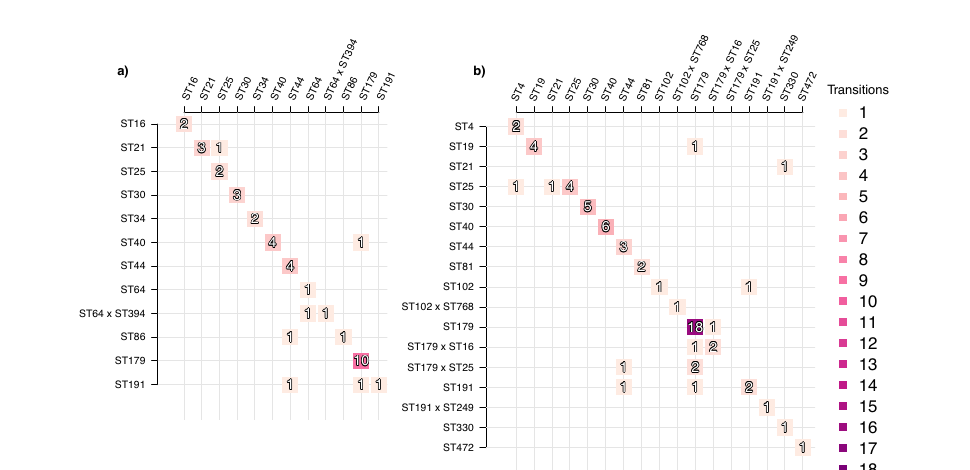
Fig. 8 | Event matrix displaying colonisation identities with respect to E. faecalis lineages between subsequent time points. The fi gure shows events corresponding to either transition from one E. faecalis lineage (rows) to another E.faecalis lineage(columns)orpersistenceofthesamelineage(diagonal). a Events